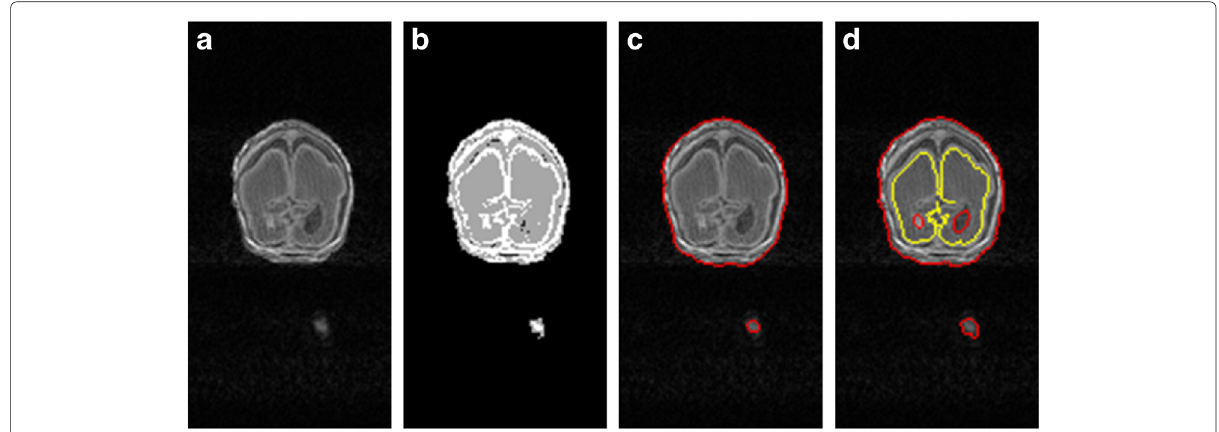
Fig. 10 Comparison with the works [22, 28]: a the 87th MR image, b result via [22], c result via [28], and d result based on our